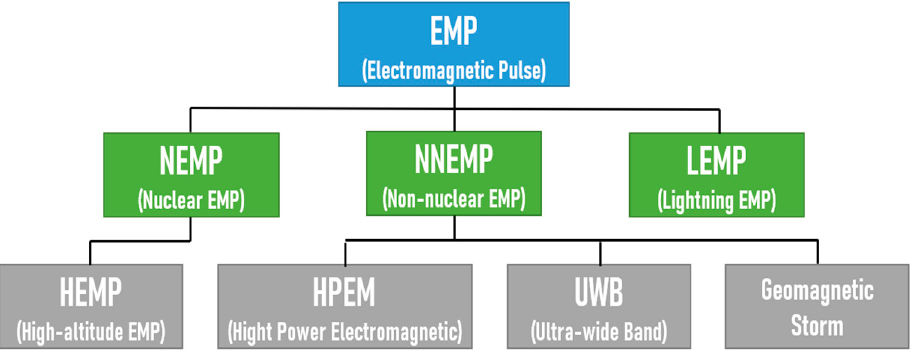
Figure 1. Classification of EMPs.